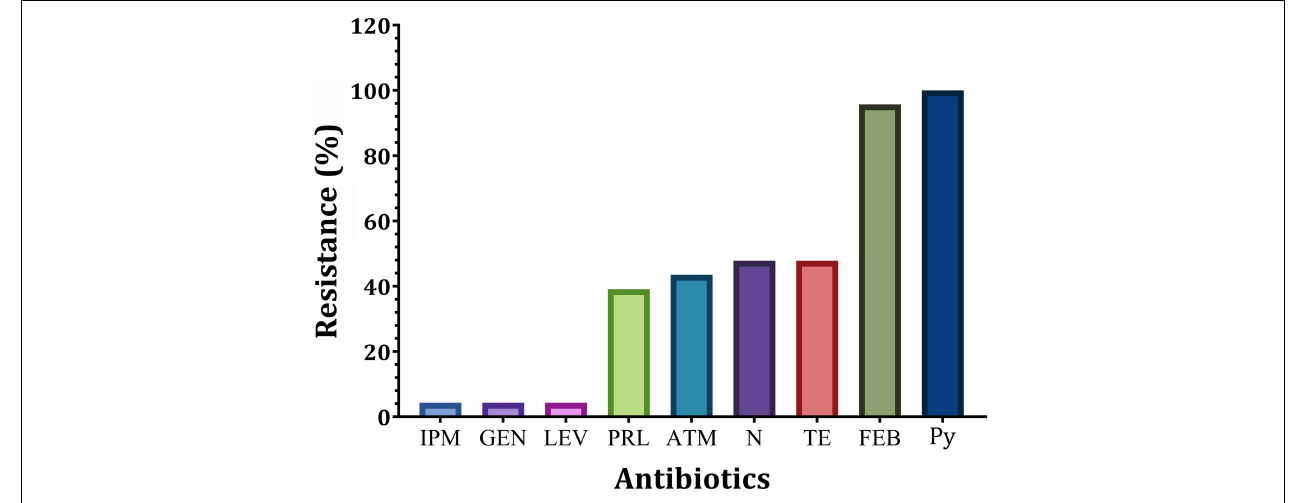
FIGURE 2 | Prevalence of resistance of P. aeruginosa isolates to different antibiotics. IPM, imipenem; GEN, gentamicin; LEV, levofloxacin; PRL, piperacillin; N, neomycin; TE, tetracycline; ATM, aztreonam; FEP, cefepime; Py, carbenicillin.